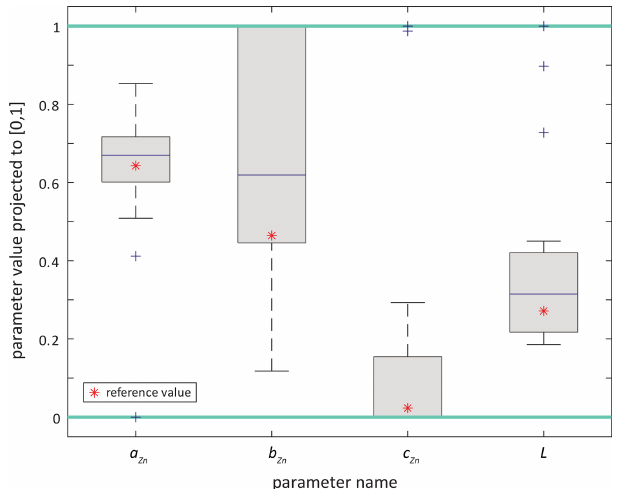
Figure 4. Boxplots of optimised parameter values obtained in all synObs_experiments, presented in parameter space rescaled to the interval [0, 1], i.e. turquoise lines at 0 and 1 correspond to boundary values for each parameter. Red stars indicate the reference parame- ter